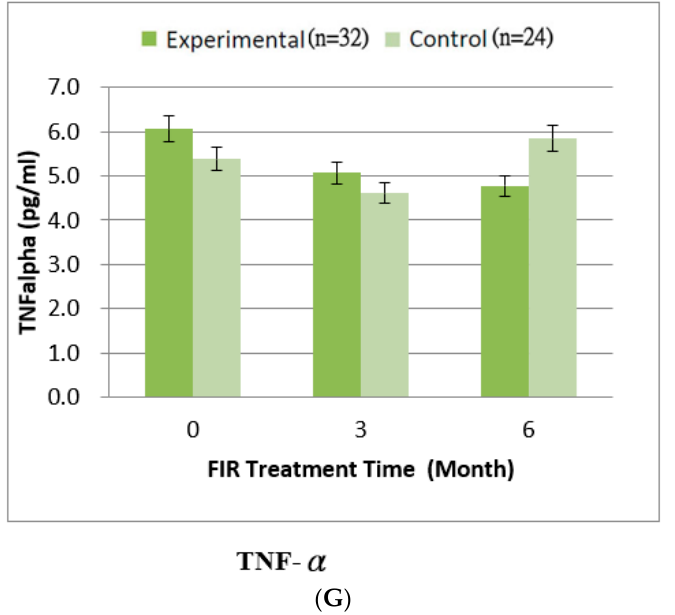
Figure 3. Comparison of clinical biochemical parameters of the experimental group (FIR) and control group (non-FIR). ( A ) IL-6, ( B ) IL-1 β , ( C ) IL-4, ( D ) IFN- γ , ( E ) IL-12p70, ( F ) IL-18, ( G ) TNF- α Table 3. Biochemical evaluation and clinical parameters of the experimental group (FIR) and control group (non-FIR).